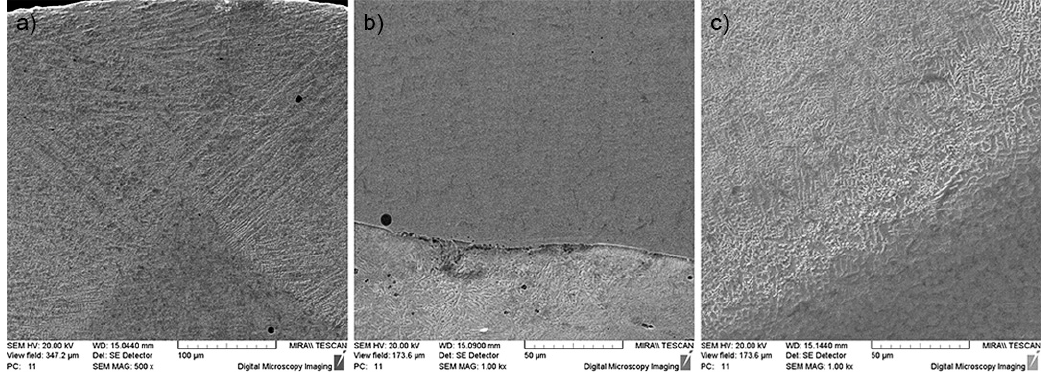
Figure 16. Microstructure of a single layer in different areas: ( а ) the track of the 12N-01 alloy in the transient zone between two tracks of bronze (VNi-al/Vbr = 120/200 mm/min, K1/K2 = 2.4/1.2 mm); ( b ) the transient zone between the tracks of the 12N-01 alloy and steel (VNi-al/Vbr = 120/200 mm/min, K1/K2 = 2.4/1.2 mm); ( c ) transient zone between the tracks of the 12N-01 alloy and bronze (VNi-al/Vbr = 160/250 mm/min, K1/K2 = 1.8/0.9 mm).